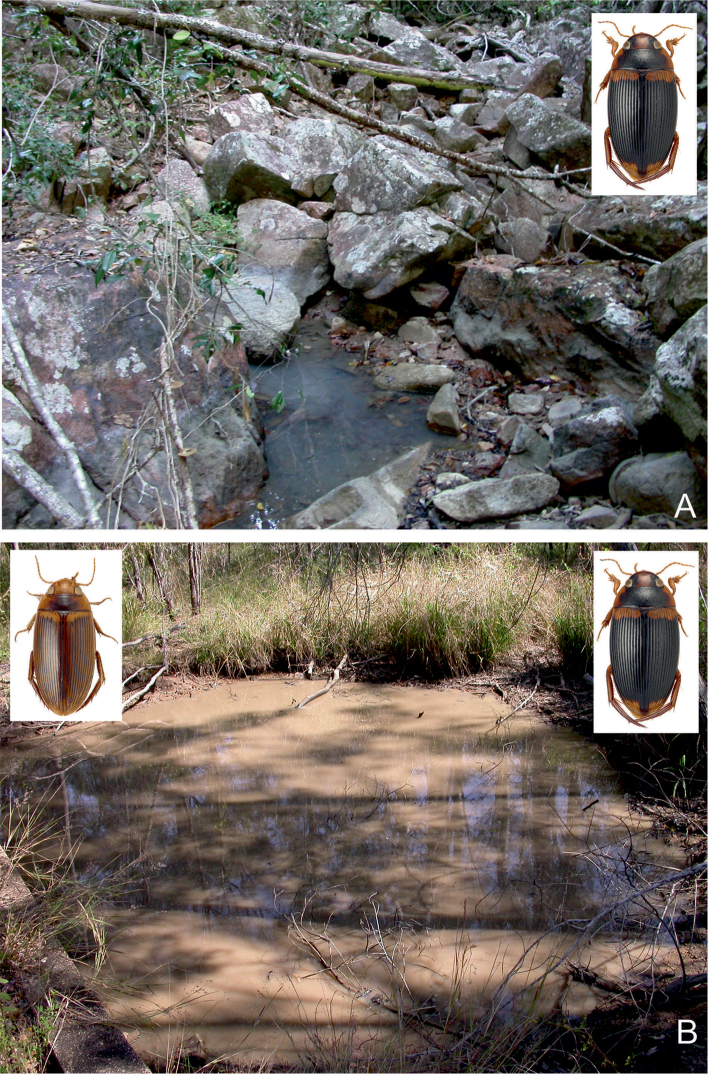
Habitat of Copelatus
irregularisA Queensland, Paluma Road 4 km west of Bruce Highway, Maiden Hair Fern Creek, 270 m, shady and rocky residual pools with rotten leaves B of C.
irregularis and C.
nigrolineatus, Queensland, Winfield, Winfield Road, muddy forest pool, rich in rotten leaves, near the street, 21 m. Photographs by L. Hendrich.